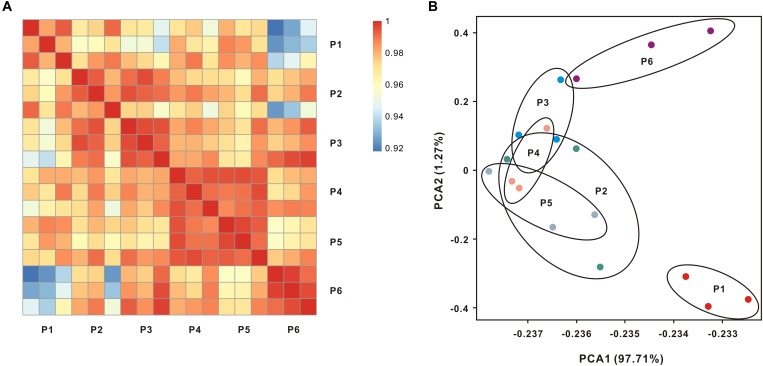
Global transcript expression profiles of oysters living across salinity gradients. (A) Expression patterns of whole transcriptomes were analyzed by means of RNA-seq quantification. The heatmap shows the square of correlation between oysters collected from different locations. Each location contains three independent biological replicates. (B) Principal components analysis (PCA) using the normalized whole transcriptome expression.